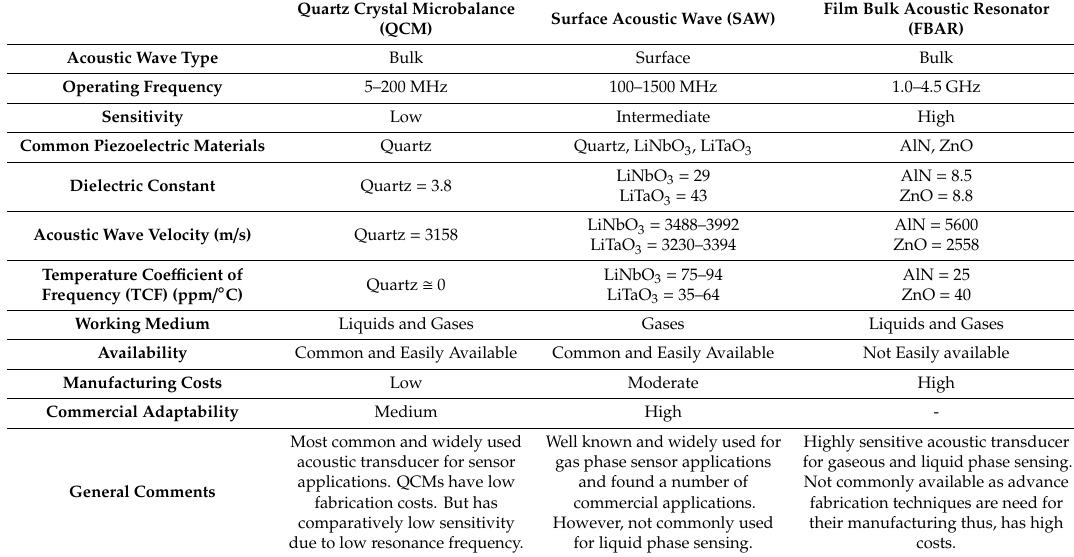
Table 1. An overview of high frequency acoustic devices for chemical / biochemical sensor applications. The acoustic wave type, operating frequency, sensitivity, nature of piezoelectric materials, dielectric constants, acoustic wave velocity, temperature coe ffi cient of frequency, working medium, availability, manufacturing costs, commercial success and general comments are described